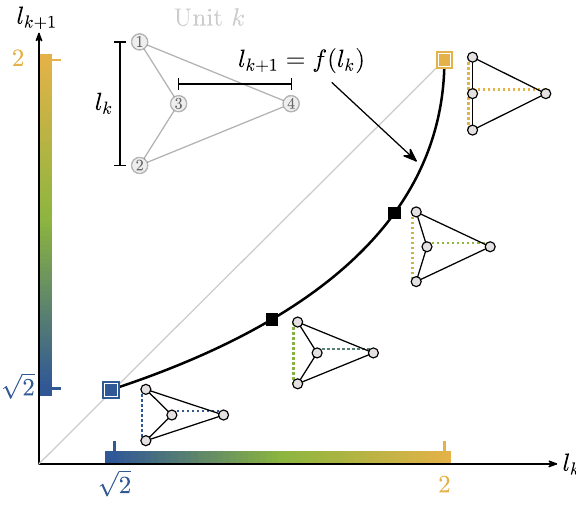
FIG. 3. Conformational motion as a map. Plot of the lengths l k and l k between unconnected nodes in the example unit (Fig. 1) þ 1 as it changes